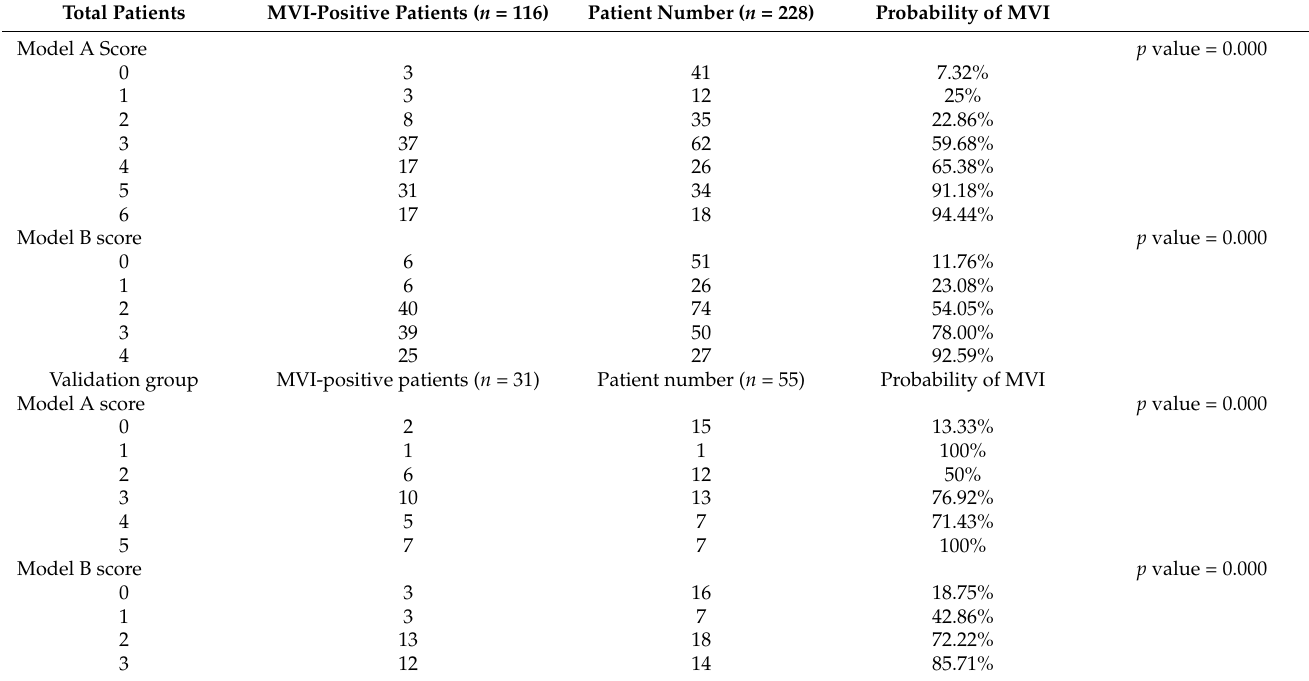
Table 4. Performance of two scoring